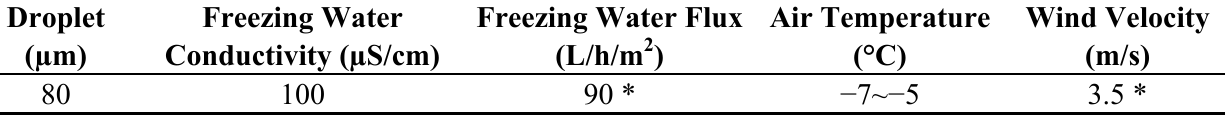
Table 2. Experimental parameters of ice